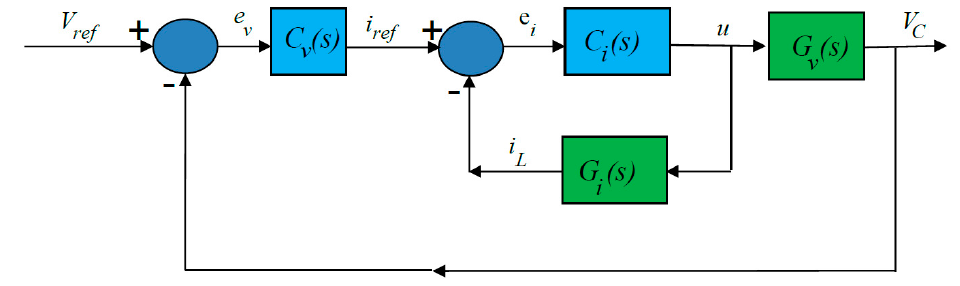
( d ) Figure 8. Effect of control weighting factor 𝑟 (cid:3050) (50, 250, 500, 1000) corresponding to cases Figure 1a,b. ( a ) Startup transient response for tracking a reference input of 24 V with an input voltage Vin = 12 V; ( b ) reference input changes from 24 V to 20 V; ( c ) reference governor signal of case ( a ); ( d ) reference governor signal of case ( b ). 6. MPC Reference Governor Design for a Two-Loop Current-Mode-Controlled Converter The developments in the previous sections considered a voltage mode control (VMC) structure, which consists of a single loop for output voltage regulation. This simplifies the control structure because the use of a current sensor is avoided, but it requires a more complicated controller (Type III). The alternative for simplifying the converter’s dynamics and the controller form is to adopt the so- called current mode control (CMC) structure, which takes a two-loop cascaded form, resulting in an